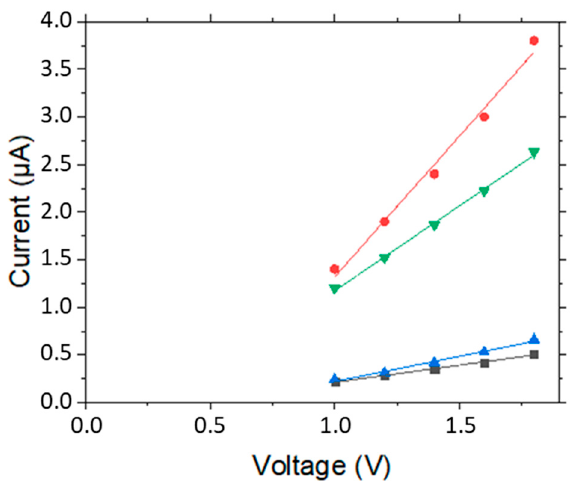
Figure A2. I–V curves of four bare devices tested at 370 °C.